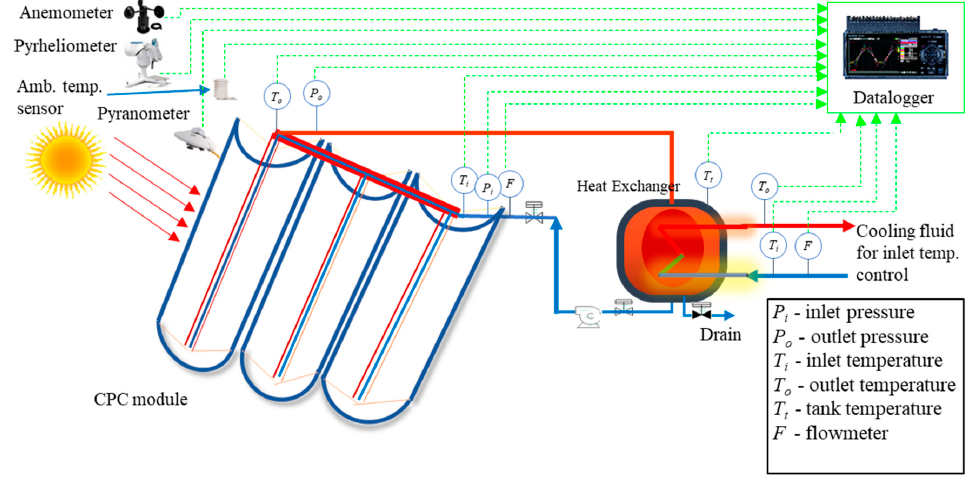
Figure 6. Schematic diagram of the experimental system.